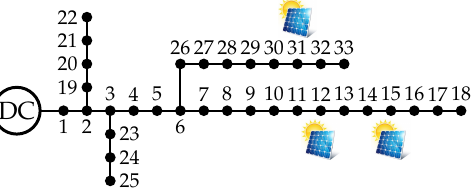
Figure 4. Adaptation of the IEEE 33-bus grid for DC monopolar